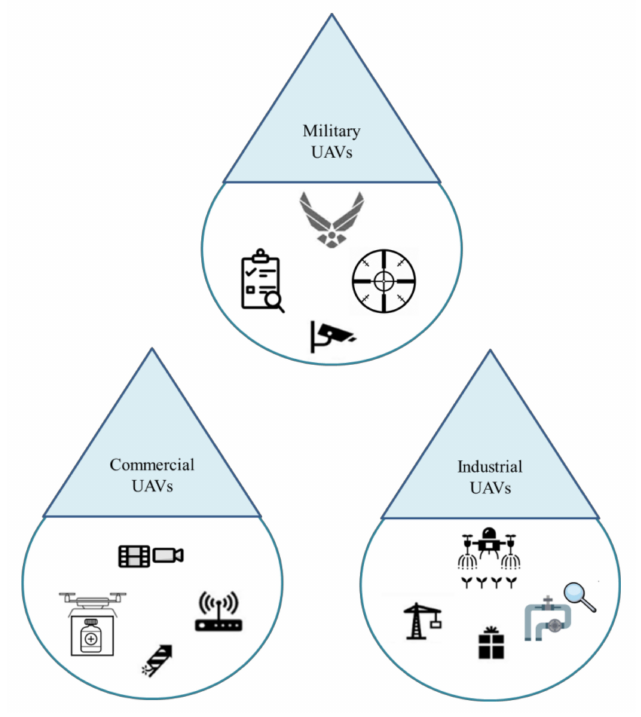
Figure 1. Applications of drones in diverse